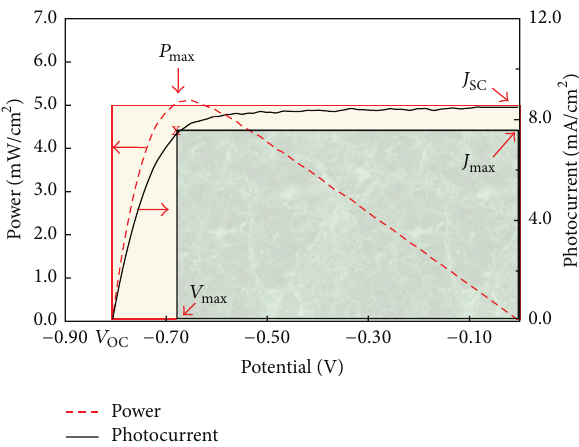
Figure 3: Representative ( 𝐽 - 𝑉 ) curve, corresponding power curve, and various terms required to calculate fill factor (FF) and power conversion efficiency of the